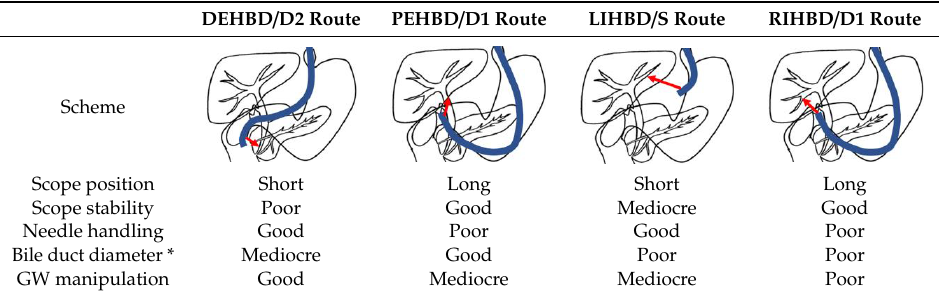
Table 1. Comparison of the approach routes.